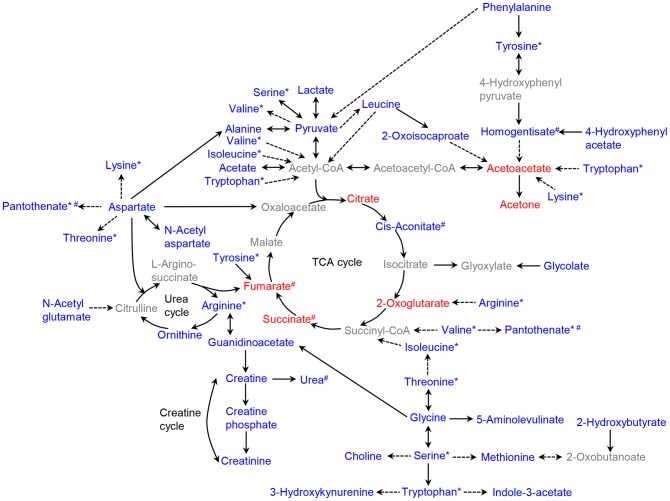
Major metabolic pathways for the metabolites that are significantly altered in urine and serum from ob/ob mice compared to lean controls, observed by 1H NMR spectroscopy.The pathways were analyzed on the basis of the KEGG pathway database (http://www.genome.jp/kegg/pathway.html). The levels of the identified metabolites that were elevated and depleted in obese mice, compared to lean mice, are color coded as red and blue, respectively, and the metabolites in gray were not identified in our study. Direction of change is shown for all obese mice including males and females. For the direction of change based on gender, see Tables 2 and 3. The metabolites with asterisk are shown several times in this diagram to avoid the complexity of the pathways. The metabolites with sharp indicate the significant ones in male or female group only. Solid and dashed arrows indicate the single and multiple steps involved, respectively, between two metabolites.